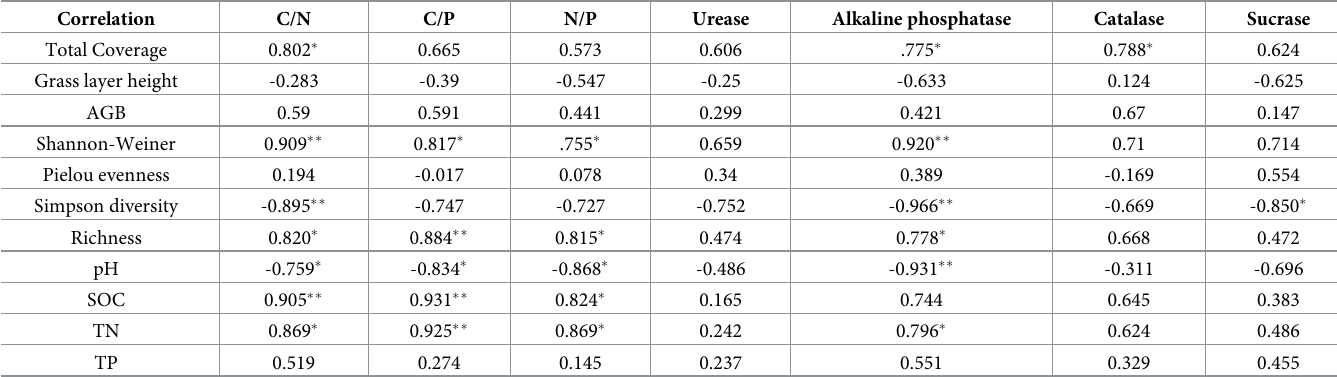
Table 3. Correlation analysis.